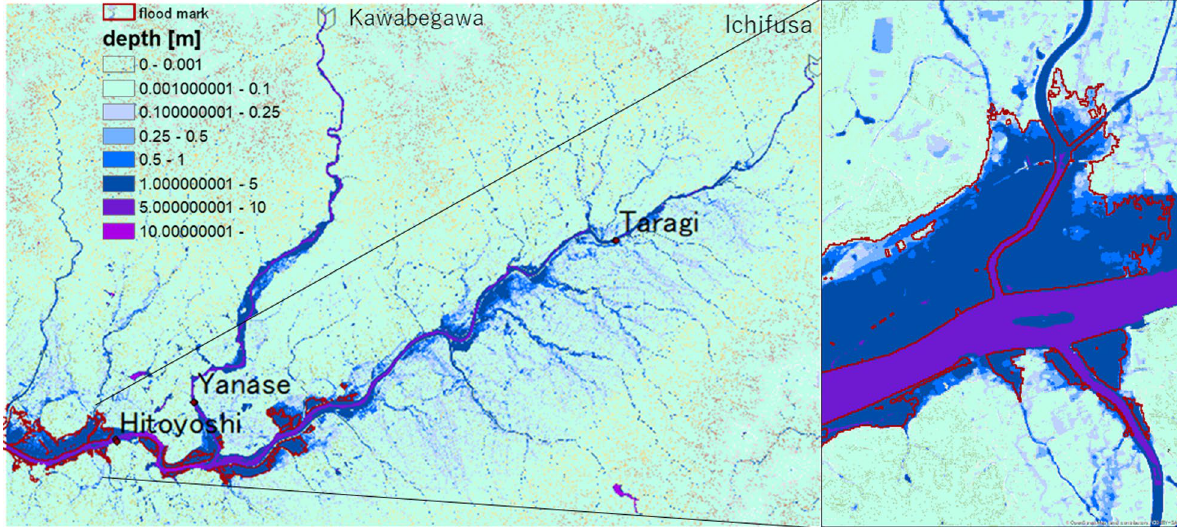
Fig. 6 Simulated water depth (2020/7/4,